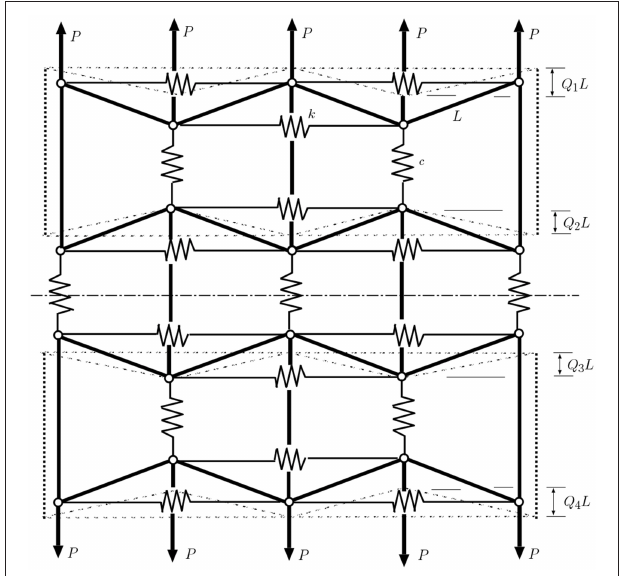
FIGURE 24 | Combined cells of the form of Figure 22 . With the centerline held stationary, displaced states are shown dashed. We refer to this configuration as a three-tier system, with four effective degrees-of-freedom Q i , i